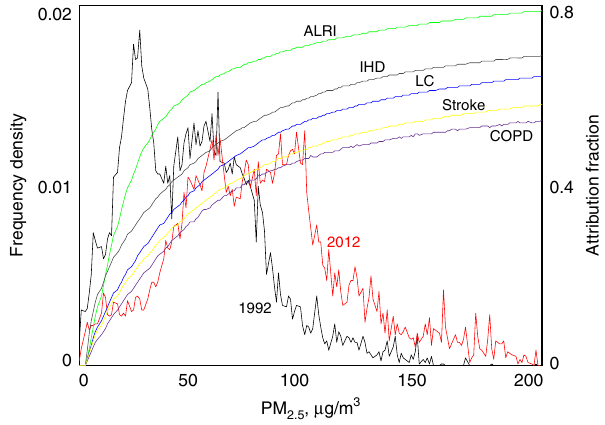
Fig. 4 Dose-response relationship and the cumulative frequency distributions of the total PWC from all sources in 1992 and 2012. The results are shown for chronic obstructive pulmonary disease (COPD), cerebrovascular disease (stroke), ischaemic heart disease (IHD), lung cancer (LC), and acute lower respiratory infections (ALRIs). Source data